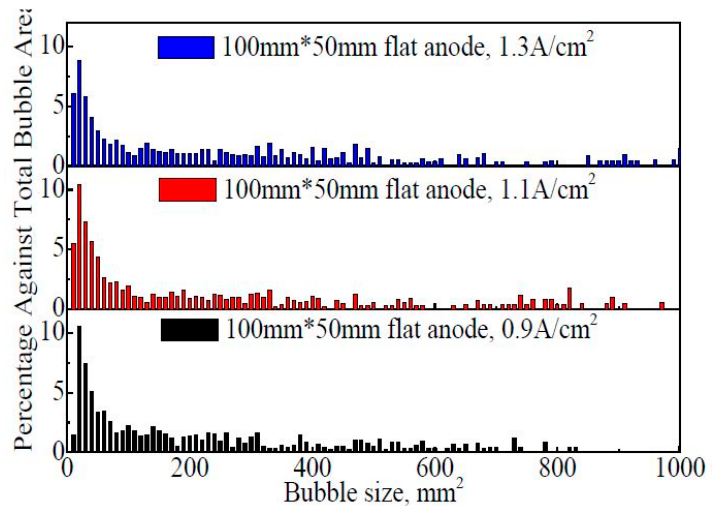
tion frequency of the actual current density curves also increased with an increasing ap- parent current density. For the 100 mm × 50 mm flat anode case, about eight bubble release cycles could be roughly distinguished within 60 s at 0.9 A(cid:31)cm − 2 . The bubble coverage var- Figure 8. The size distribution of the bubbles on the 100 mm × 50 mm flat anode within 60 s. ied from 7% to 54%, with the average coverage of 30% at 0.9 A(cid:31)cm − 2 . It is found that there are fluctuations in the real apparent current den- sity with time, but the fluctuation frequency is not stable (at least not as stable as it was with the 50 mm × 22 mm flat anode in Figure 7a). The fluctuation range of the actual cur- rent density is reduced to 1.0–2.0 A(cid:31)cm − 2 at the apparent current density of 0.9 A(cid:31)cm − 2 , in contrast to 1.0–4.1 A(cid:31)cm − 2 on the 50 mm × 22 mm flat anode under the same situation. The average actual current density within 60 s showed a slight increase with the increasing apparent current density, at 1.31 A(cid:31)cm − 2 ,1.33 A(cid:31)cm − 2 , and 1.37 A(cid:31)cm − 2 , respectively, un- der the apparent current density of 0.9 A(cid:31)cm − 2 , 1.1 A(cid:31)cm − 2 , and 1.3 A(cid:31)cm − 2 . The fluctua-